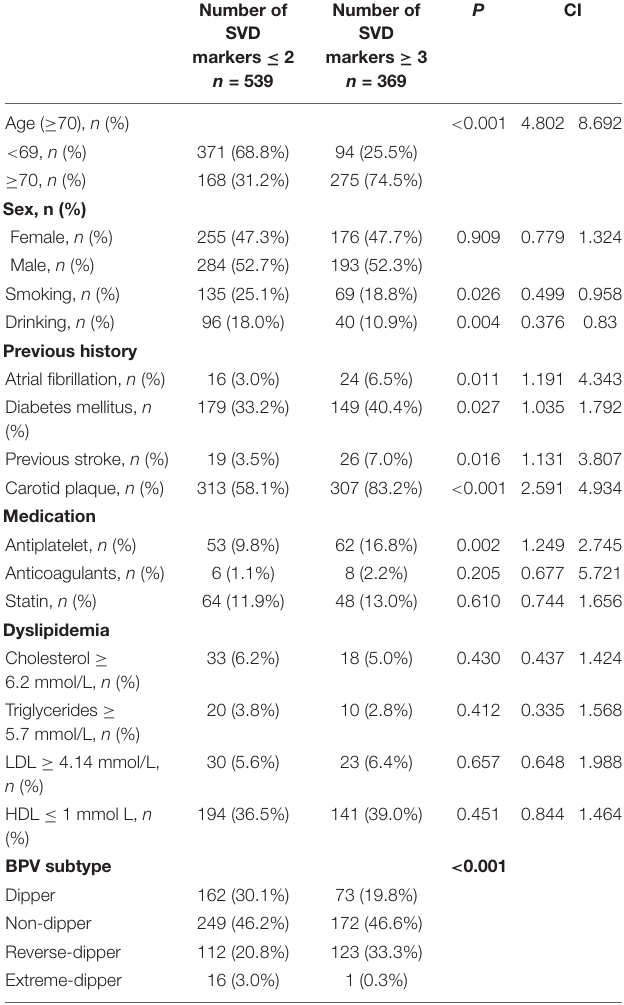
TABLE 5 | Univariate analysis of predictors of the number of small vascular disease (SVD) markers ≥ 3.